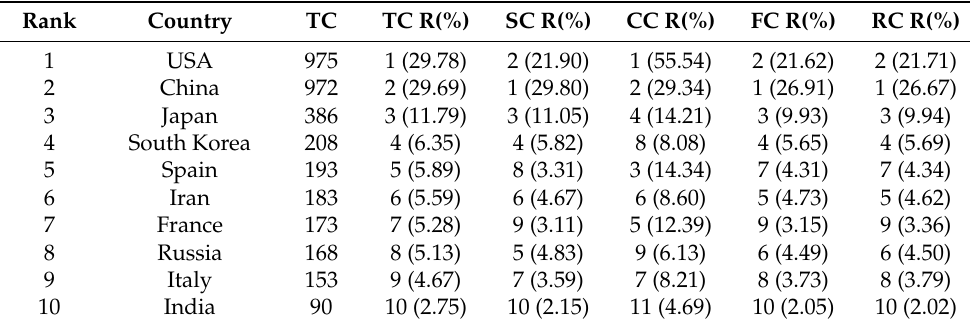
Table 1. Top ten countries (regions) that published papers from 1998 to